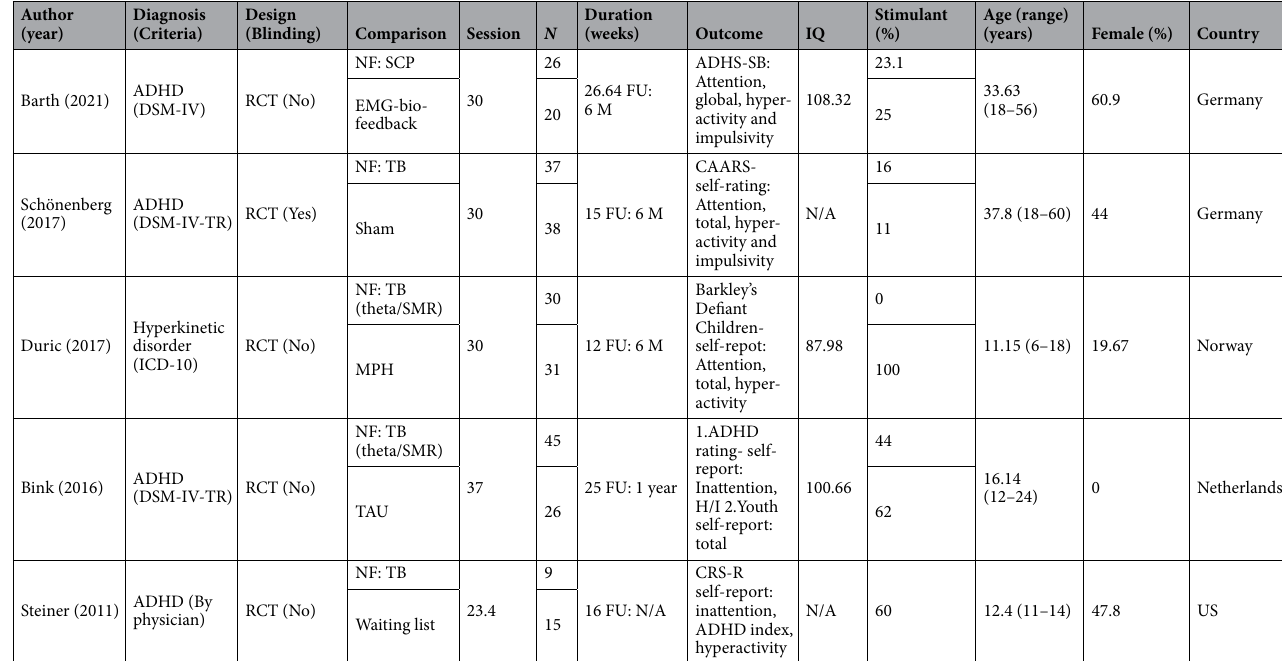
Table 1. Summary of characteristics of studies in the current meta-analysis. ADHD, Attention deficit and hyperactivity disorders; ADHS-SB German ADHD self-rating scale for symptoms in adulthood; CAARS Conners’ adult ADHD rating scale; CRS-R, Conners’ Rating Scale – revised; DSM-IV Diagnostic and Statistical Manual of Mental Disorders, fourth edition; DSM-IV-TR, Diagnostic and Statistical Manual of Mental Disorders, fourth edition, text revision; EMG electromyography; FU follow up; H/I, hyperactivity/ impulsivity; ICD-10 International Classification of Diseases, Tenth Revision; IQ intelligence quotient; MPH, methylphenidate; M month; N, number; N/A not available; NF, neurofeedback; RCT randomized controlled trial; SCP slow cortical potentials; SMR, Sensorimotor rhythm; TAU, treatment as usual; TB, theta/beta training; yr